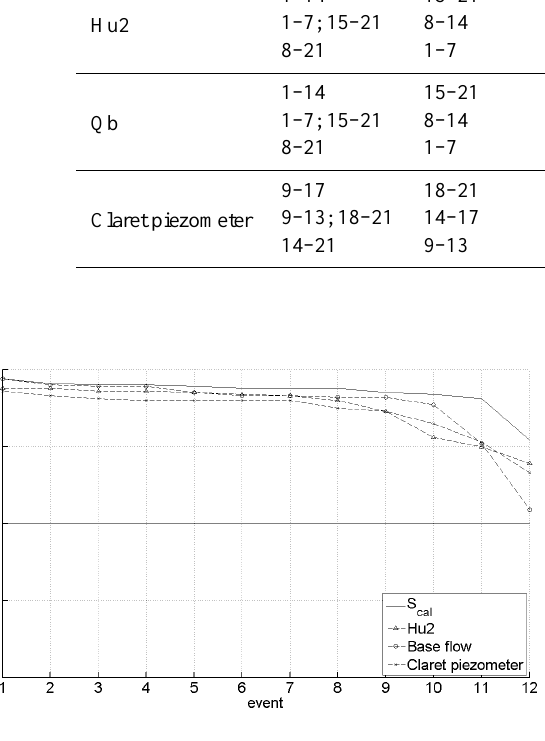
Fig. 9. Nash event values sorted by descendant order for each ini- tialization method, i.e. S obtained by calibration (S cal ) or by initial- Figure 9: Nash event values sorted by descendant order for each initialization method i. e. S 4 ization with Hu2 index, Claret piezometer or base obtained by calibration (Scal) or by initialization with Hu2 index, Claret piezometer or base 5 flow. 6